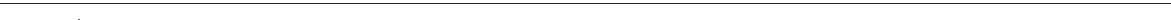
FIGURE 2 | (“dynamic”) samples (B3–6) , which were generated by nanopore sequencing (B2, B4, B5, B6) or by LoopSeq (B3) (C) Read length distribution in the various samples. (A) Virus:host ratio of transcription reads. This study yielded altogether 3,463,245 viral and 22,337,732 host transcript reads. The first six samples were prepared by mixing RNAs isolated from time-varying samples before library preparation using equal volumes of RNA solution taken at each time point (1, 2, 4, 6, 8, and 12h post infection; “mixed time points” in the gray chart). “A-B-C” in the gray chart include those 1 and 2h samples, which contain combined data of the three biological replicates. The rest of the bars depict the virus:host ratio of time-course data obtained from three sample series (A–C, each representing a biological replicate) which were generated using nanopore sequencing (samples from time points 1, 2, 4, 6, 8, and 12h), or via LoopSeq (samples from time points 2 and 12h). Reverse transcription was carried out using oligo(dT) oligonucleotide primers in each case, except in two samples where random oligonucleotide primers were used (labeled as “random”). Some of the cDNA libraries were generated using PCR amplification (labeled as “acDNA,” where “a” stands for “amplified”), the rest of the cDNA samples were non-amplified (labeled as “dcDNA,” where “d” stands for “direct”). “Hu-Mi” refers to the mixed time points from the Hungarian and Mississippian samples, which were sequenced using barcode labeling. A small ratio of the barcode sequences had lower sequencing quality. These reads were not excluded because they can be used for further analysis of the virus. LRS: long-read sequencing. (B) Viral read ratios in the different samples. The first pie chart diagram (B1) shows the relative proportion of the total viral reads generated by the various sequencing approaches. More than half of the viral reads were produced by direct cDNA (dcDNA) sequencing technique, whereas 0.4% of the total reads were generated by the LoopSeq technique. The second pie chart diagram (B2) illustrates the proportions of non-time-varying (“static”) transcript reads obtained by nanopore sequencing. Charts B3–B6 represent the relative proportions of time-varying (“dynamic”) reads generated by LoopSeq (B3) or nanopore dcDNA sequencing (B4–6) at different time points. The ratios of the three biological replicates (samples A–C) of the LoopSeq data (2 and 12h samples) are depicted in a single chart, while the nanopore data (1, 2, 4, 6, 8, and 12h samples) were illustrated in three